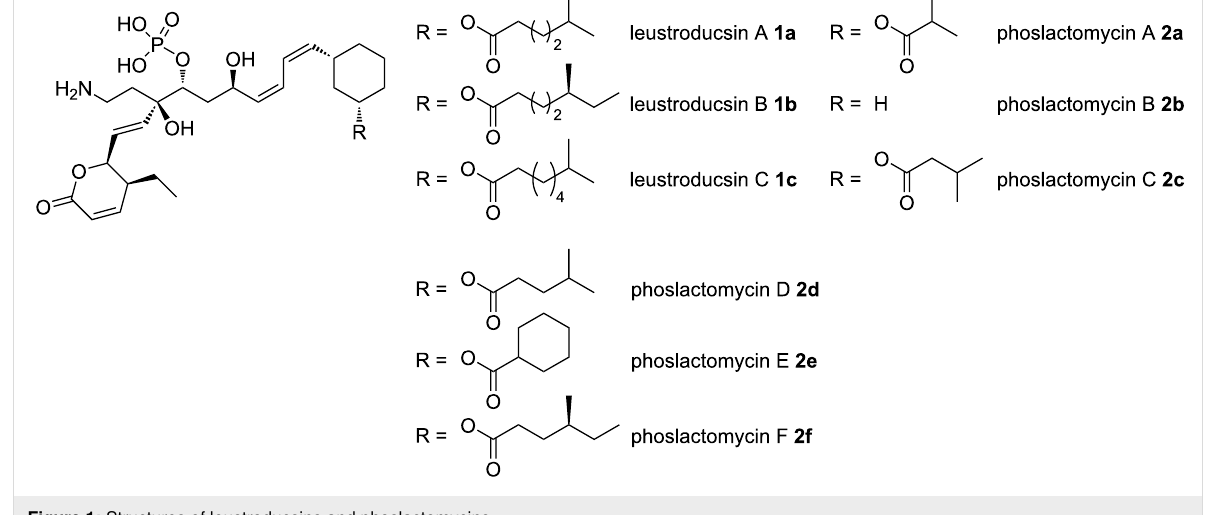
Figure 1: Structures of leustroducsins and phoslactomycins.